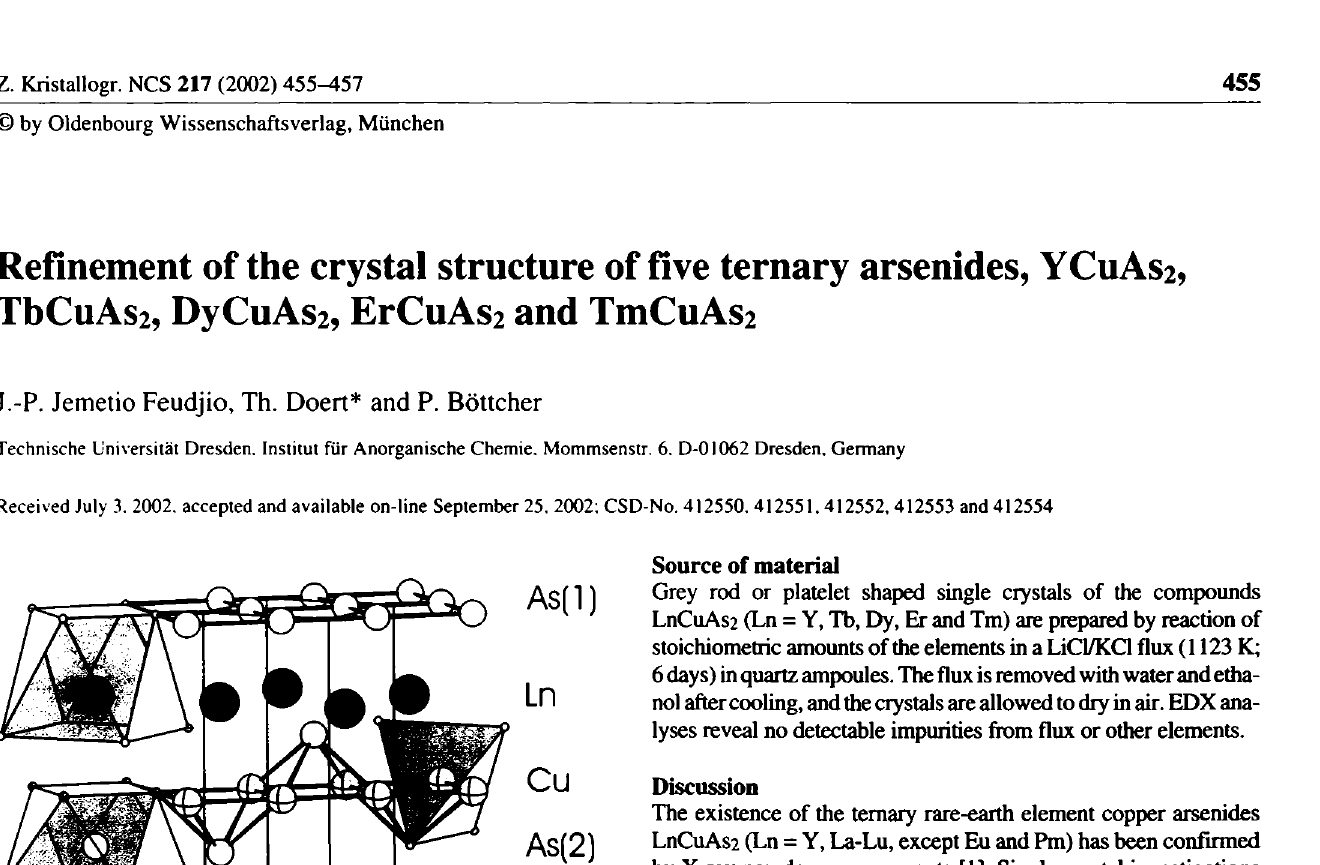
Table 1. Data collection and handling. Crystal: Wavelength: